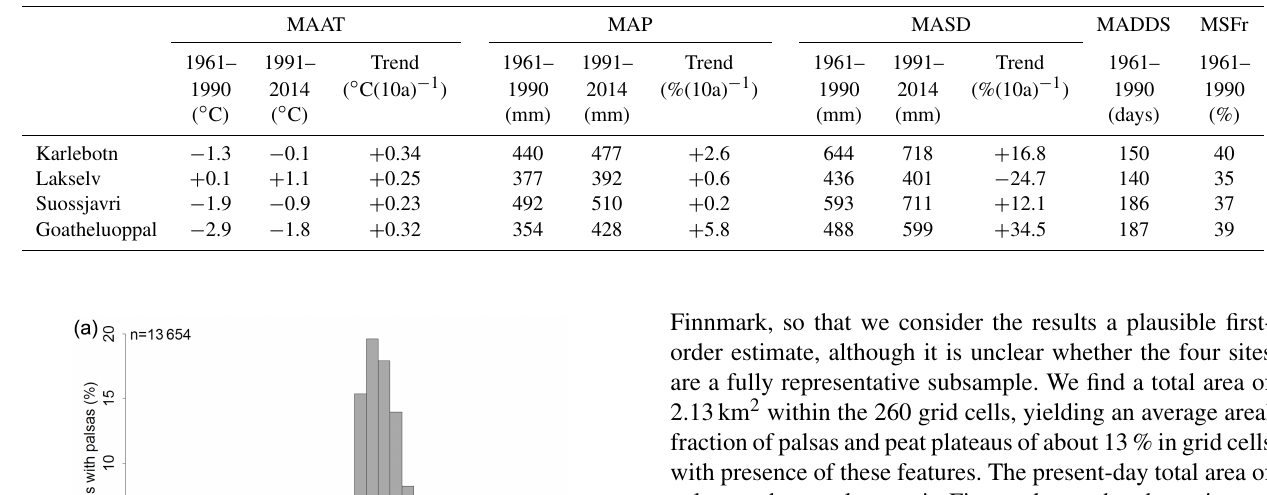
Table 2. Data of mean annual air temperature (MAAT), mean annual precipitation (MAP), mean annual maximum snow depth (MASD), mean annual days of dry snow (MADDS) and mean snow fraction of total precipitation (MSFr) during the period 1961–1990 and 1991–2014 at the four study areas, including linear trends for MAAT, MAP and MASD based on simple linear regression. The data are based on the seNorge (2016) data set.